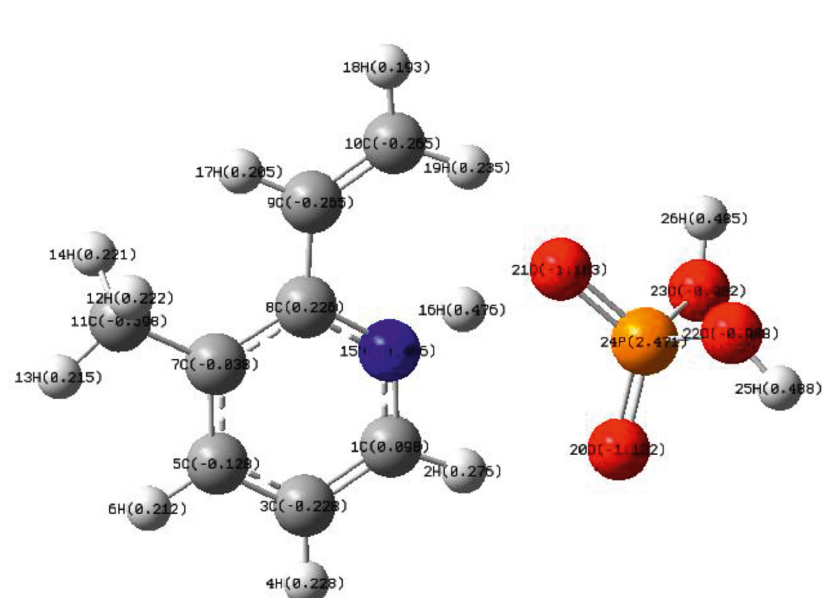
Figure 3: NBO charges of